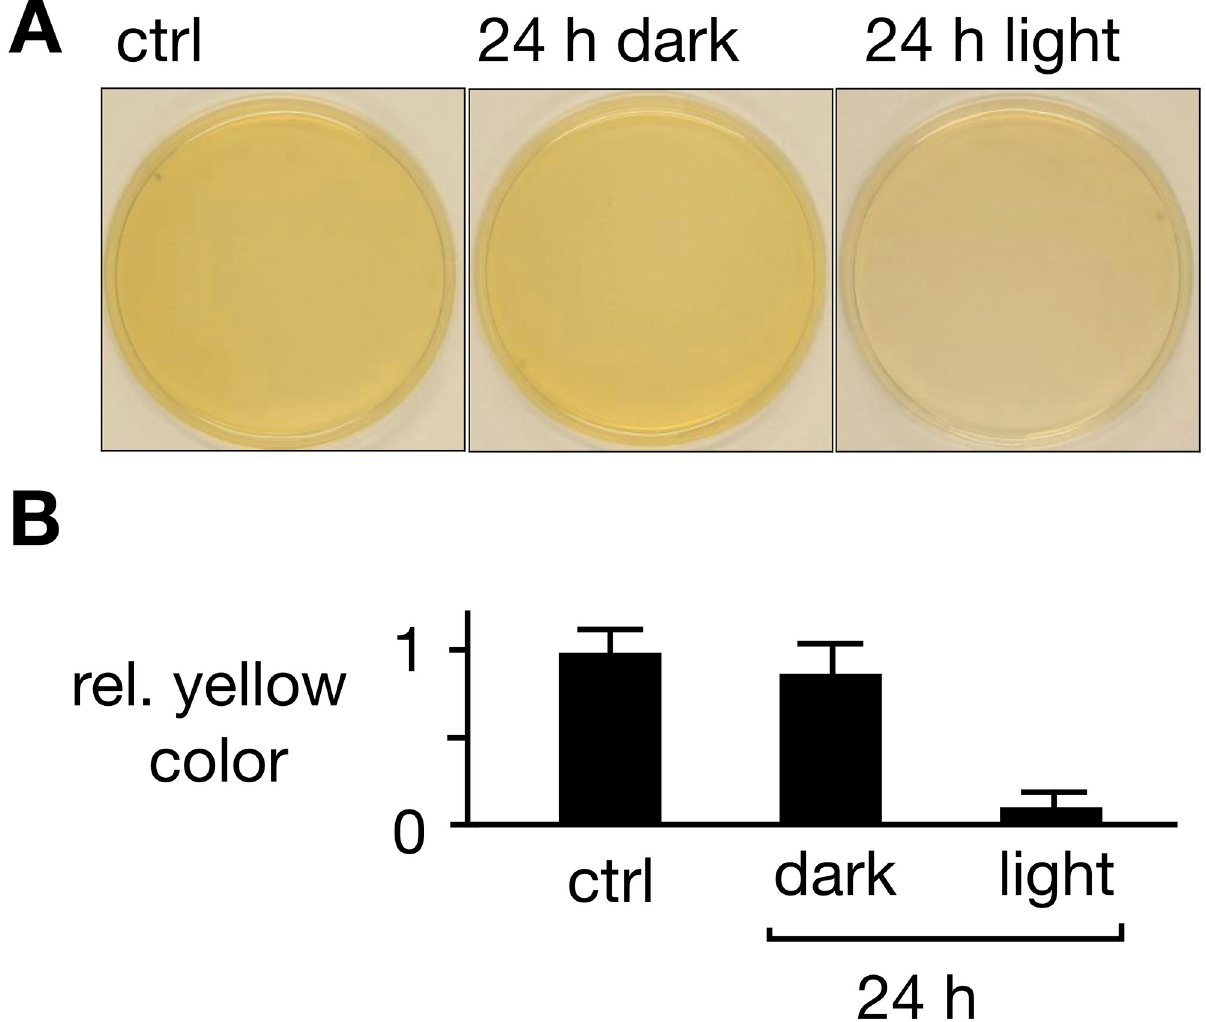
Fig 2. Illumination bleaches retinal in medium. (A) Agar plates containing 1 mM retinal directly after preparation (left, ctrl) and 24 h after keeping plate in the dark (center, 24 h dark) or in the light (right, 24h light, right). Illumination bleaches retinal-containing agar. (B) Yellow color of agar plate above background was obtained from deconvolution of images and plotted as relative value of plates after 24 h incubation in light or dark relative to pre-incubation (ctrl). Mean ± SD of independent replicates.